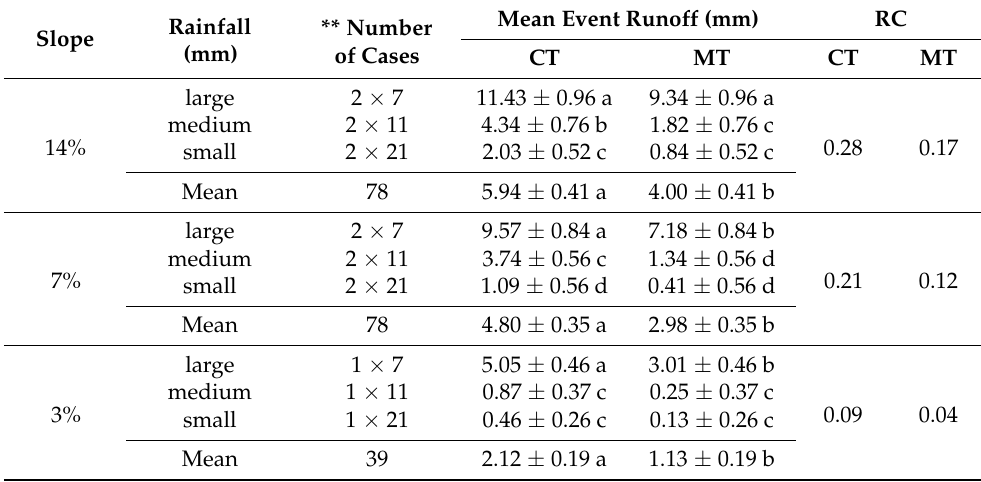
Table 1. Mean event runoff and coefficient values under CT and MT practices on maize-cultivated plots for the total (39) monitored days in years 1 and 2.